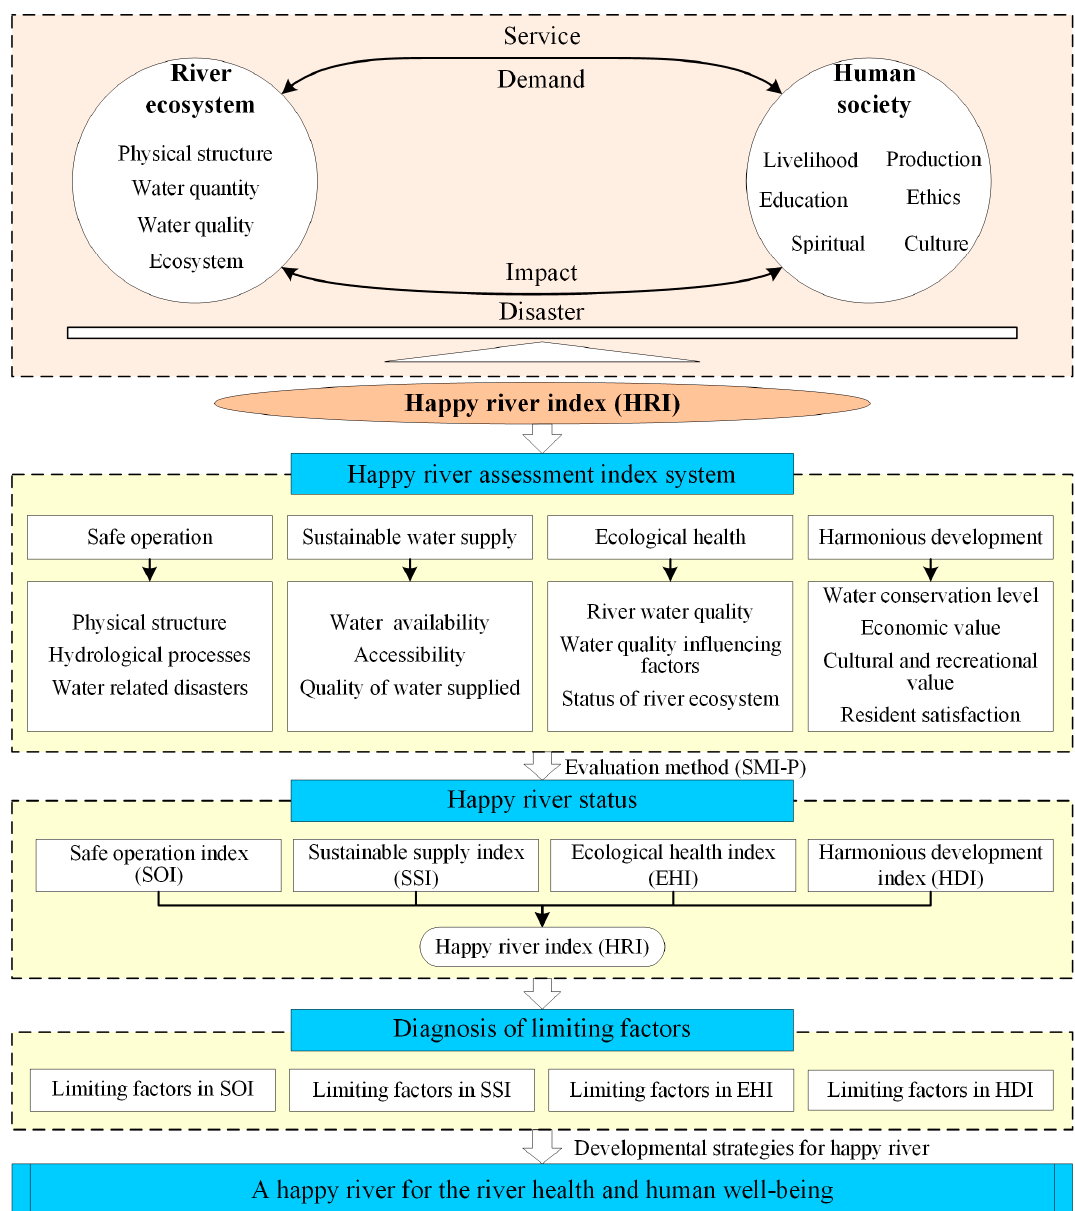
Figure 1. A proposed framework for the happy river assessment.